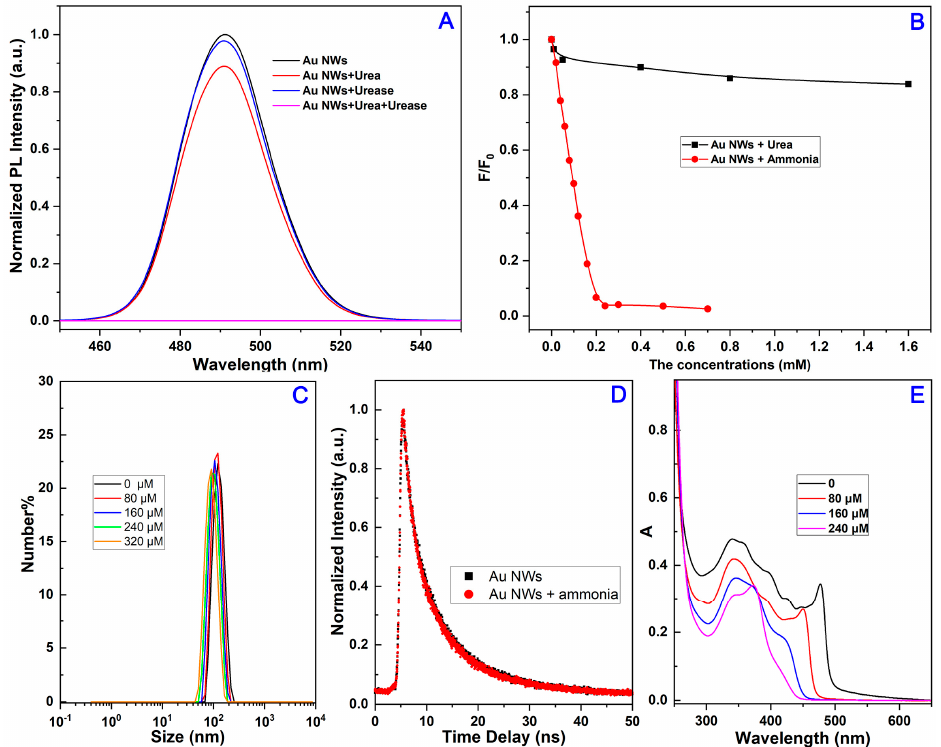
Figure 4. ( A ) The fluorescence spectra of Au NWs, Au NWs + urea, Au NWs + urease, and Au NWs + urea + urease. ( B ) The effect of the concentration of urea (square) and ammonia (circle) on the fluorescence intensity of Au NWs. ( C ) DLS with different concentrations of ammonia, ( D ) fluores- cence lifetime, and ( E ) UV-vis absorption of Au NWs with different amount of